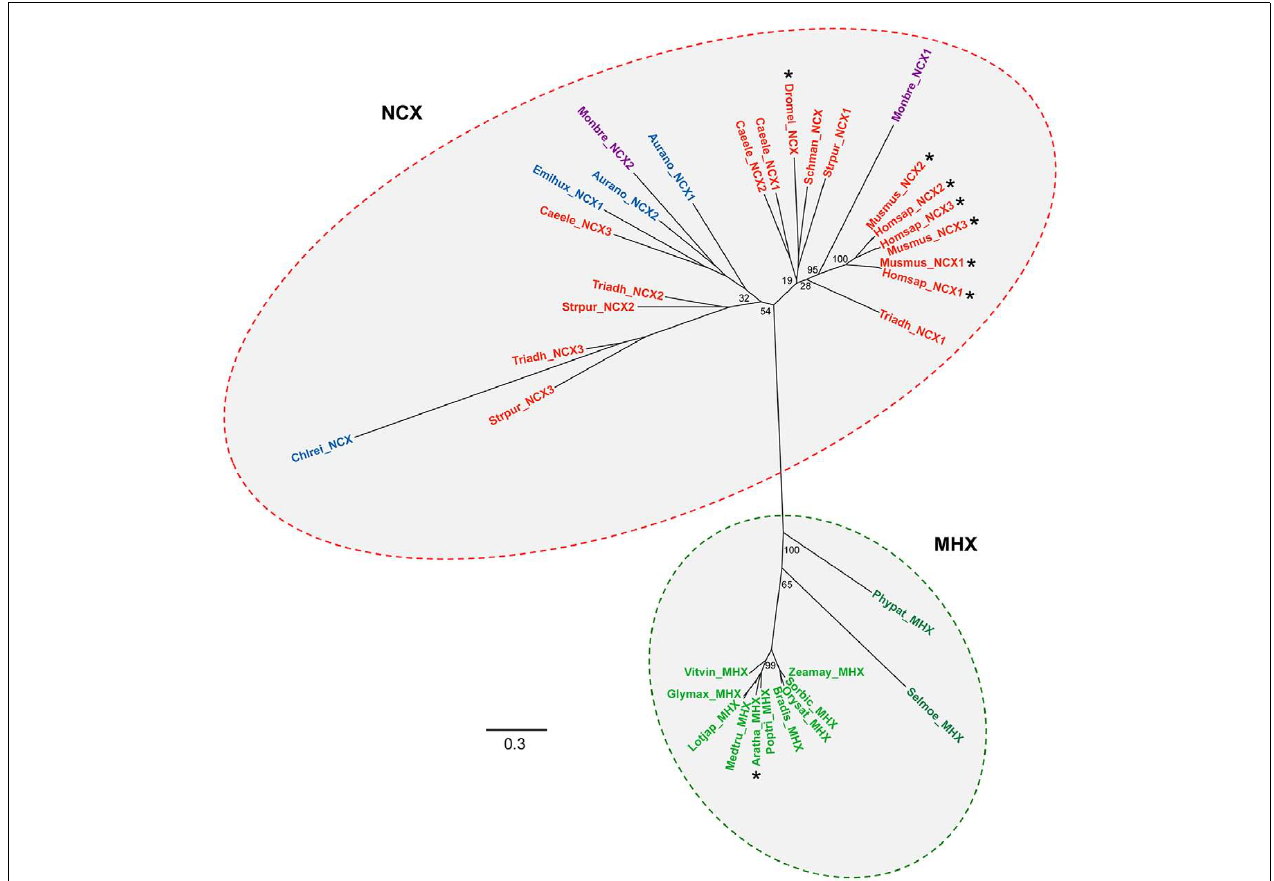
to the species class using the same color code as in Figure 3 . Bootstrap values are indicated at the nodes of major branches.The branch length scale bar indicates the evolutionary distance of 0.3 amino acid substitutions per site. Genes that are highlighted with an asterisk encode transporters for which the ion specificity has been